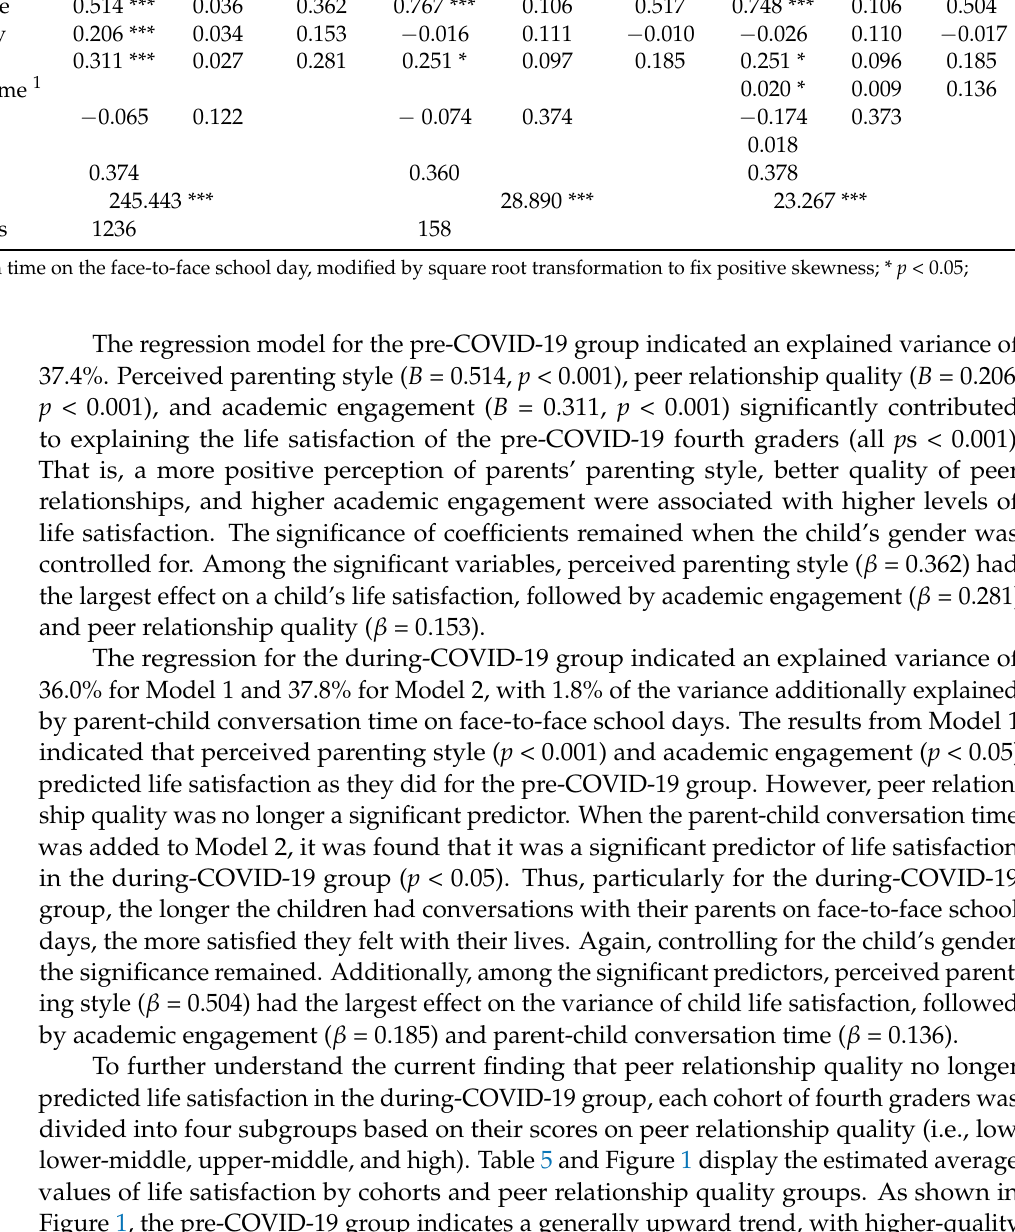
Table 4. Predictors of life satisfaction before and during COVID-19 pandemic. Pre-COVID-19 During-COVID-19 Model 1 Model